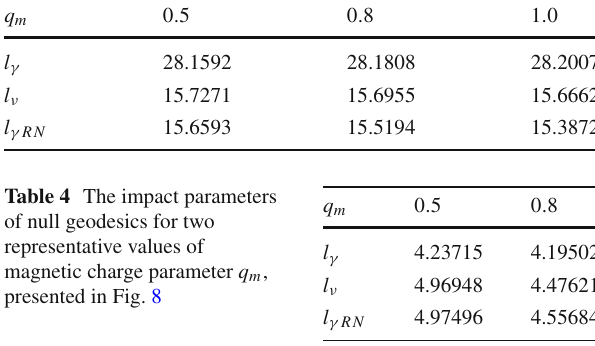
Table 3 List of impact parameters l i ( i = (γ,ν,γ RN ) ) for geodesics connecting observer and emitter at r = 100 separated by azimuthal angle φ = π of particular spacetime